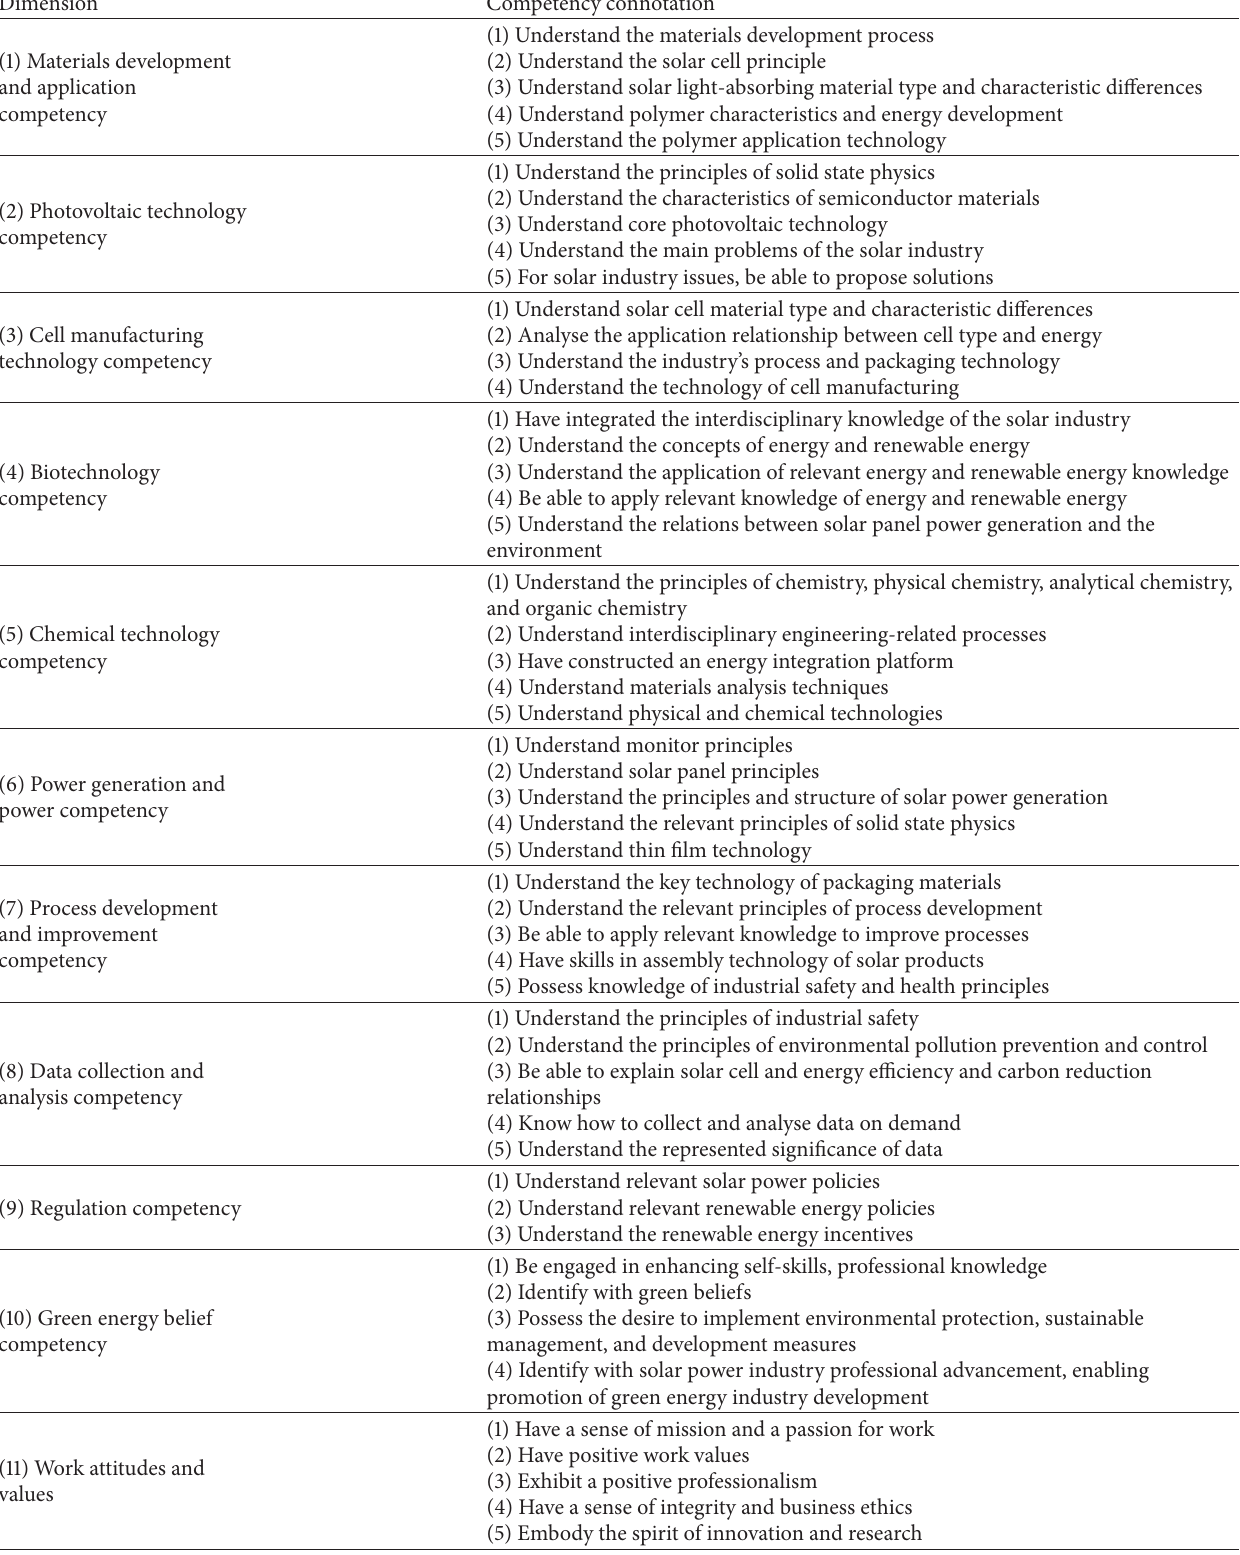
Table 2: The solar professional competency dimensions and